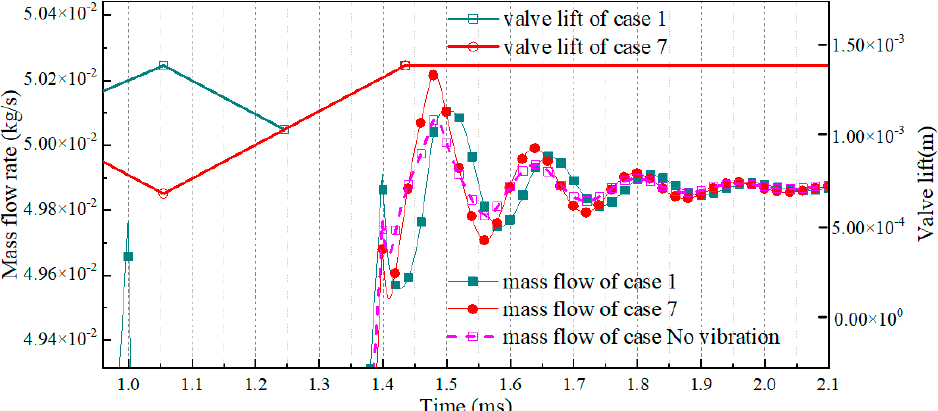
Figure 11. Valve lift vibrations and mass flow rates of case 1 and case 7 (they had the same valve vibration speed).